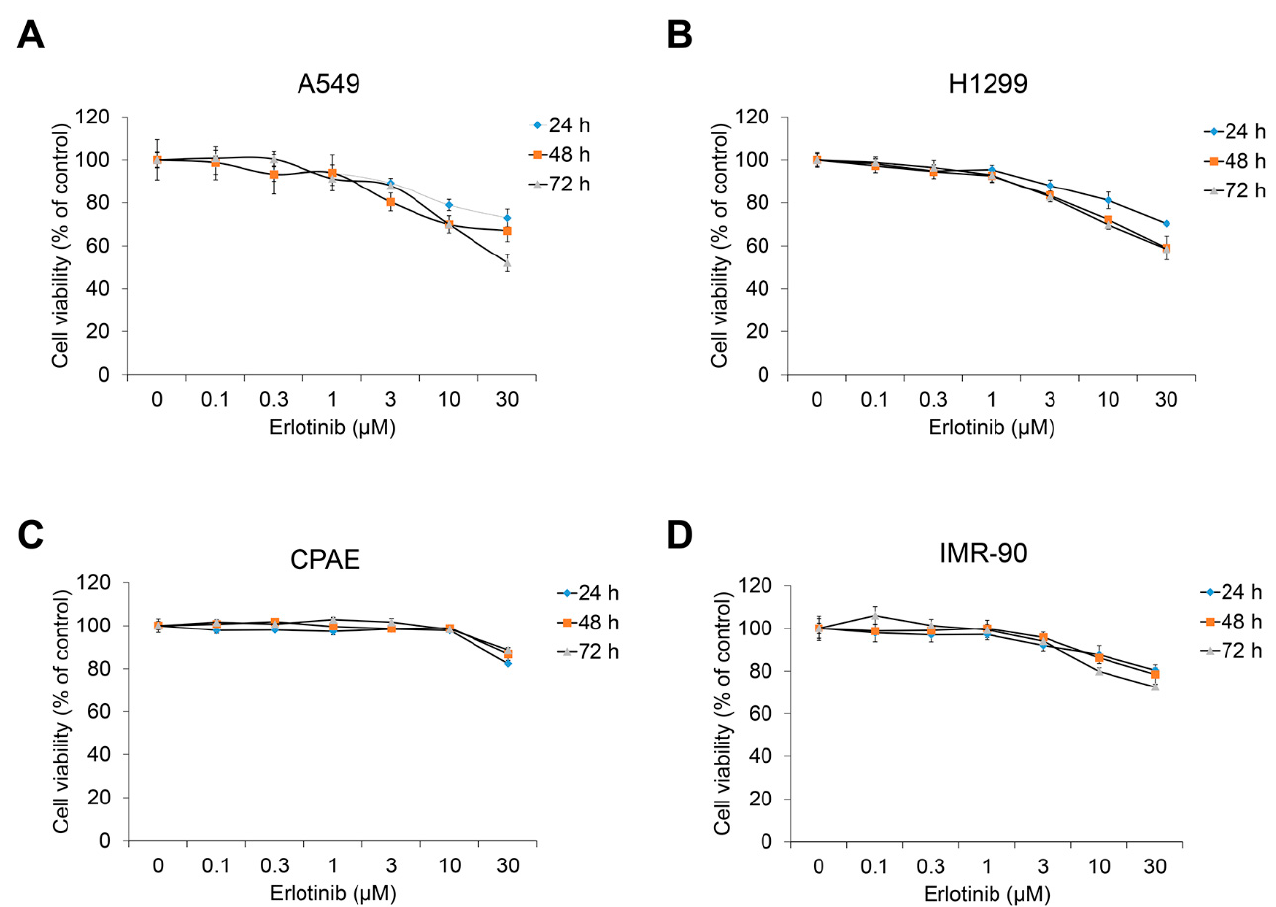
Figure 1. Erlotinib inhibits proliferation of human NSCLC A549 and H1299 cells. ( A ) A549, ( B ) H1299, ( C ) CPAE, and ( D ) IMR90 cells were treated with erlotinib for 24–72 h. After incubation, cell viability was measured by the EZ-Cytox Enhanced Cell Viability Assay Kit. Experiments were performed in triplicate. Data represent mean ± SD.